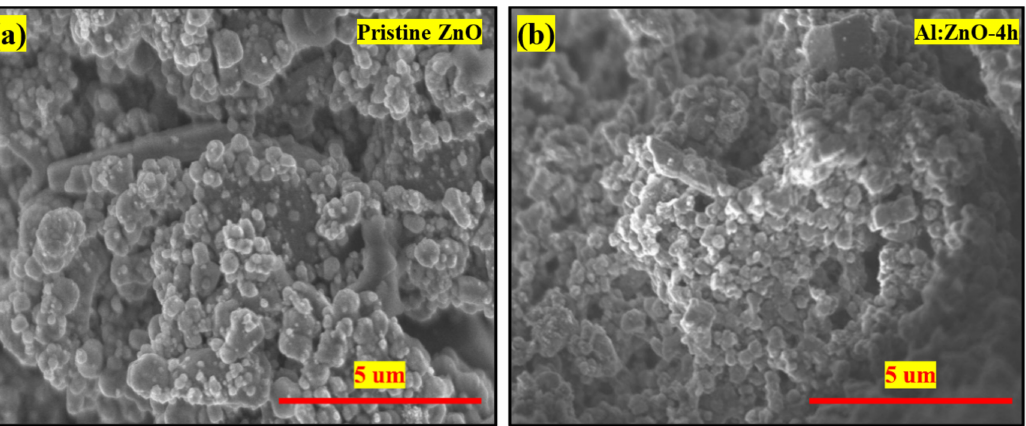
Figure 6. FESEM morphology ( × 10,000 magnification; 5 kV applied voltage) of the ( a ) pristine ZnO and ( b ) Al:ZnO-4 h nanostructured-based flexible humidity sensor deposited on cellulose filter